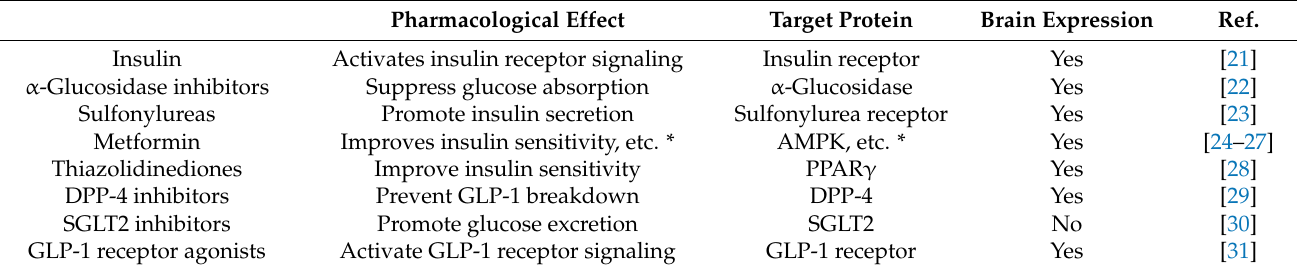
Table 1. Antidiabetic drugs that target proteins and their brain